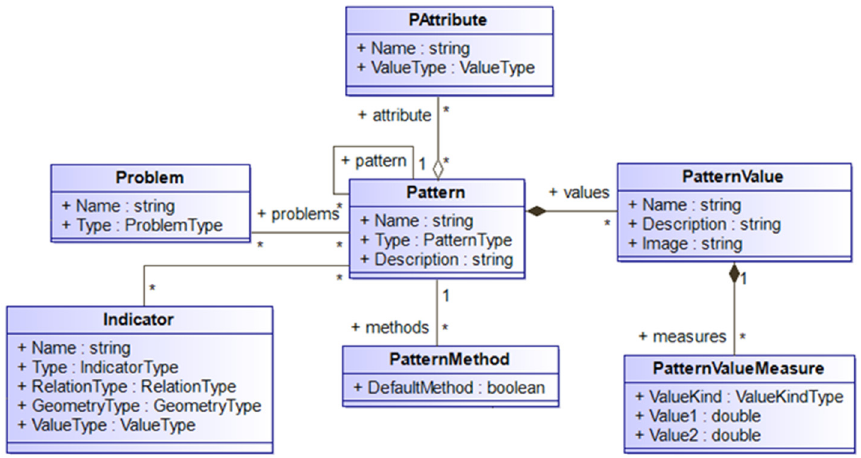
Figure 6. General SP and meta-pattern model (UML class diagram).